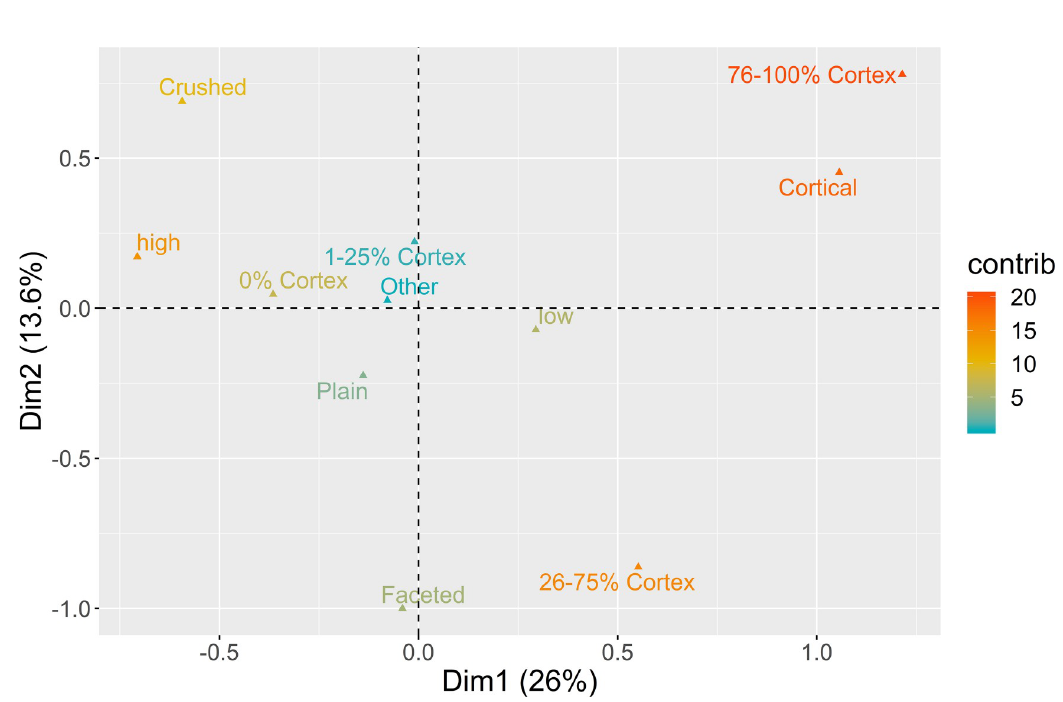
Fig 5. Multiple correspondence analysis plot (first two dimensions) for platform maintenance. The color ramp represents the contribution (in %) of the variable categories to the definition of the dimensions.